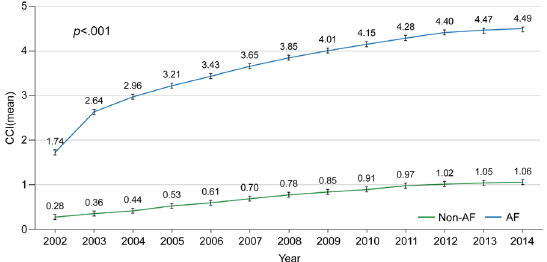
Fig. 1 Carlson comorbidity index trends according to atrial fibrillation diagnosis (Whiskers indicate standard deviation of mean. AF Atrial fibrillation, CCL Charlson comorbidity index) Fig. 2 The Atrial fibrillation Better Care (ABC)